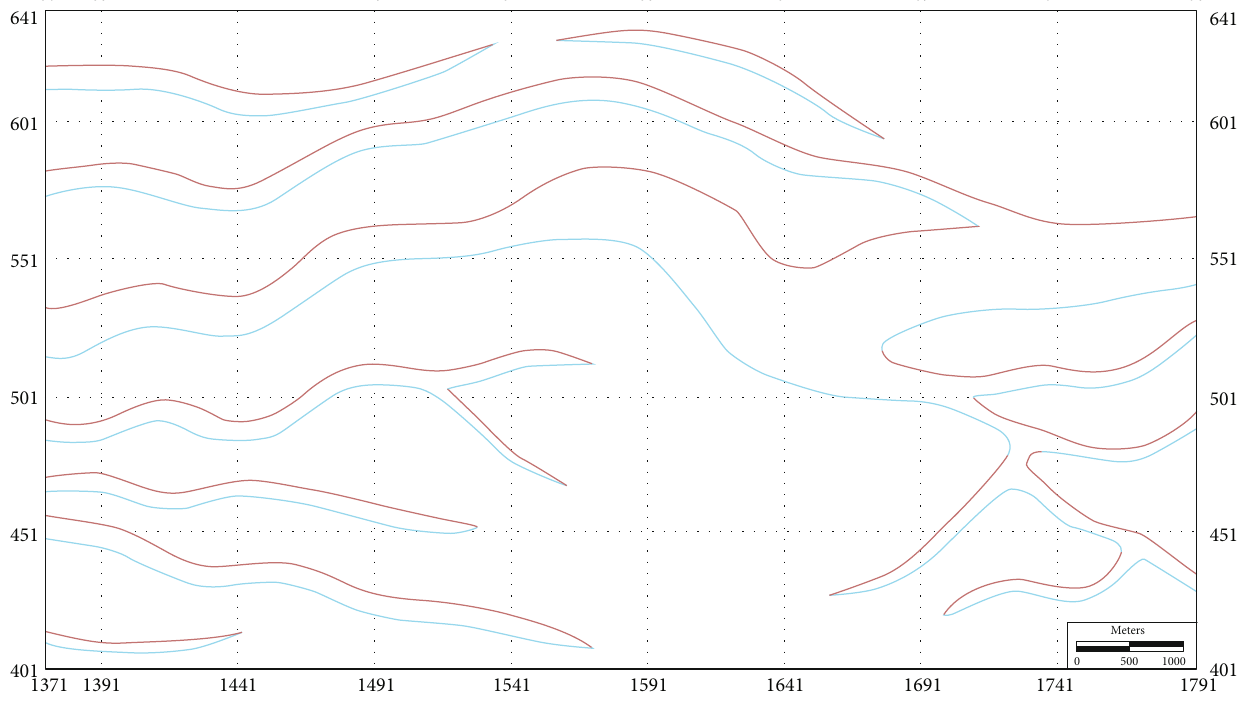
Figure 6: T6 re fl ector plane fracture